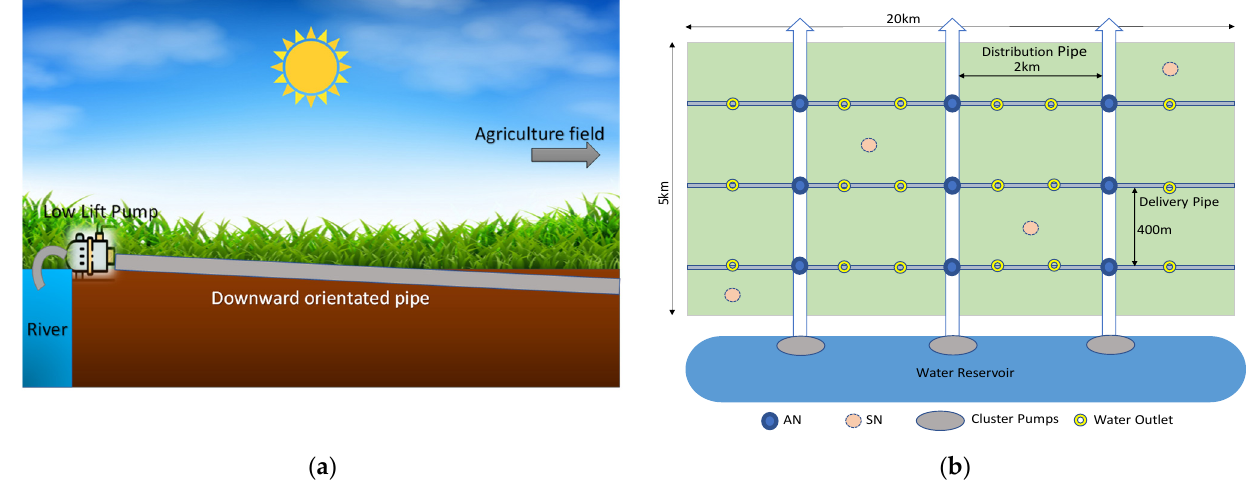
Figure 6. ( a ) Downward slope water pipe ( b ) In-field Automated AWD setup. According to Equation (8), 250 units of 0.1262 m 3 /s (2000 GPM) capacity pumps need to be formed into clusters to ensure that the field is reflooded within 16 to 17 h of operating time. The frictional head loss for a steady pipe’s flow is calculated using the Hazen–Williams equation [59], which is given by Equation (11).